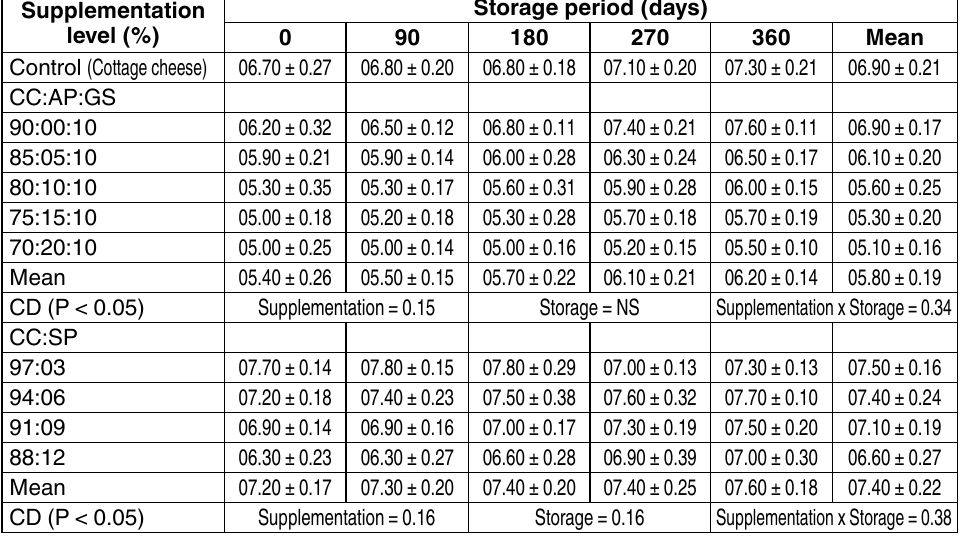
Table 3. Effect of supplementation and storage on texture of value-added churpe products (balls and strips) Supplementation level (%)